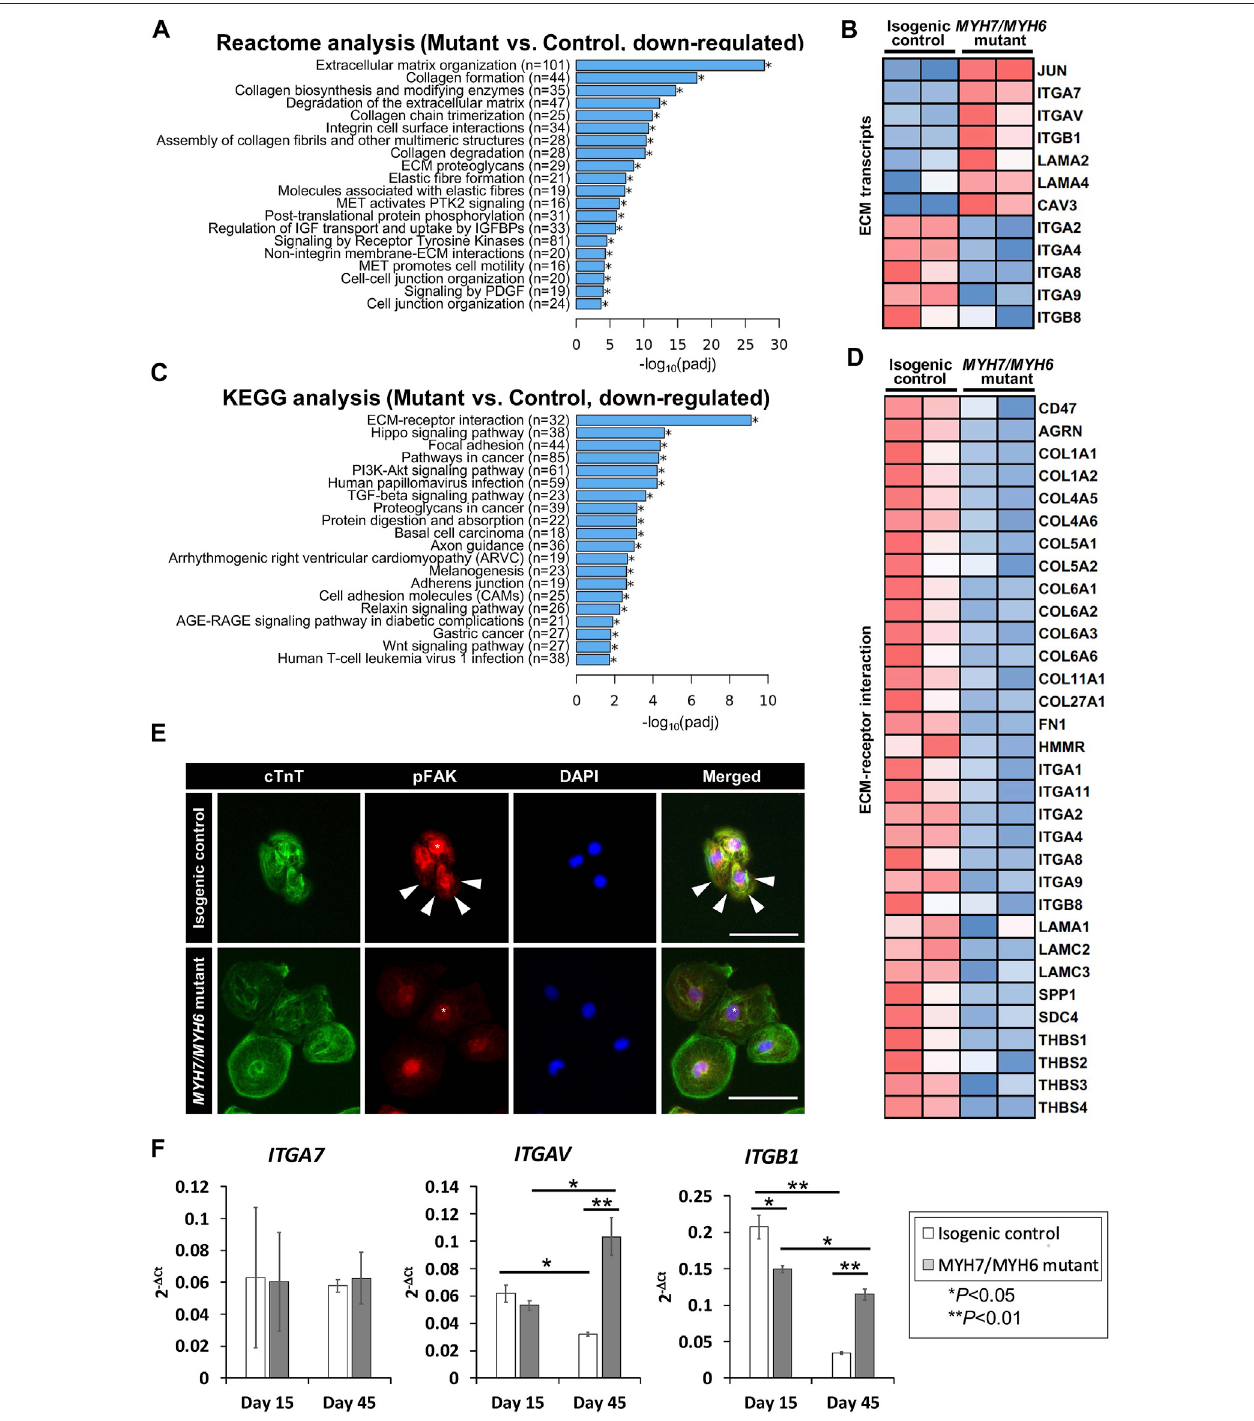
FIGURE 6 | MYH7/MYH6 mutation drives altered ECM dynamics and ECM-receptor interaction. (A) Reactome analysis showing the top 20 annotated down- regulated pathways in the mutant as compared to control lines. Note that the most signi fi cantly dysregulated were the pathways associated with ECM organization. (B) HeatmapshowingthedysregulatedtranscriptsinvolvinginECM. (C) Top20annotatedpathwaysdeterminedbyKEGGanalysiswithdown-regulatedDEGlist.Notethat ECM-receptorinteractiontranscriptsweremostsigni fi cantlyaltered inthemutant cellsrelativetocontrolcells. (D) Heatmap forup-regulatedDEGsthatassociated with ECM-receptor interaction. (E) Representative images of cTnT and pFAK-immunostained hiPSC-CMs using isogenic control and mutant cells. White stars point out nucleus locationandwhitearrows indicateactivated FAKsignal at thevicinityofthecell-substrate attachmentsite. DAPIlabels thenuclei(blue). (Scale Bar=100 μ m) (F) qPCR analysis for ITGA7 , ITGAV , and ITGB1 transcripts using RNA isolated from control and mutant cardiomyocytes at Day 15 and Day 45 of differentiation. Data represents mean ± SEM; * p < 0.05; ** p < 0.01; Student t test; n = 4 cell lysate samples per condition.